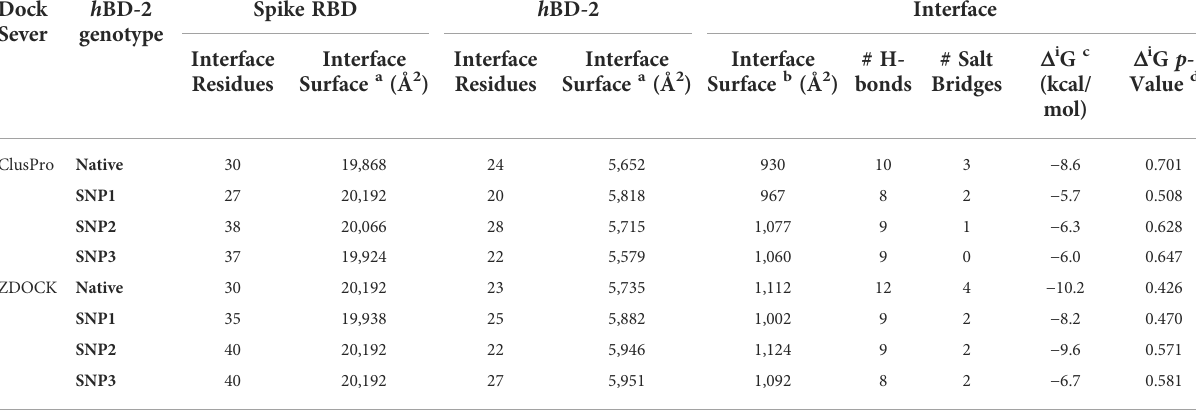
TABLE 5 Descriptors of the spike RBD/ h BD-2 interface analysis predicted via PDBePISA server. Dock Sever